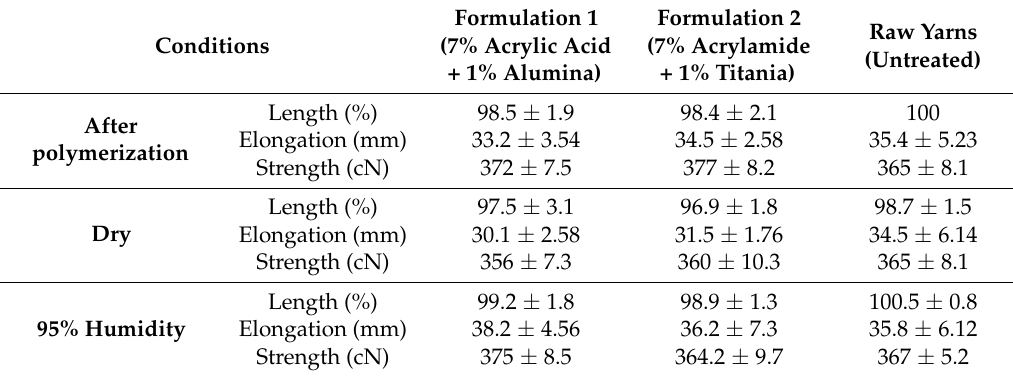
Table 1. Length, elongation and strength variation of wool yarns samples coated on different hydrogel formulations. The percentage calculated is based on the original length of the yarn (50 mm). Five samples were tested for each